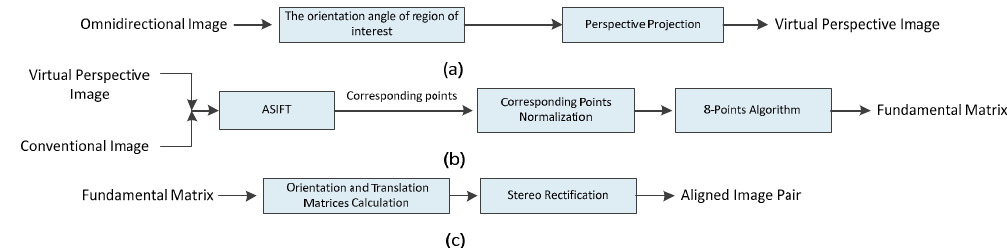
Figure 1. Block diagram of the proposed automatic rectification approach. ( a ) Acquisition of the virtual perspective image. ( b ) Calculation of the fundamental matrix. ( c ) Stereo rectification.